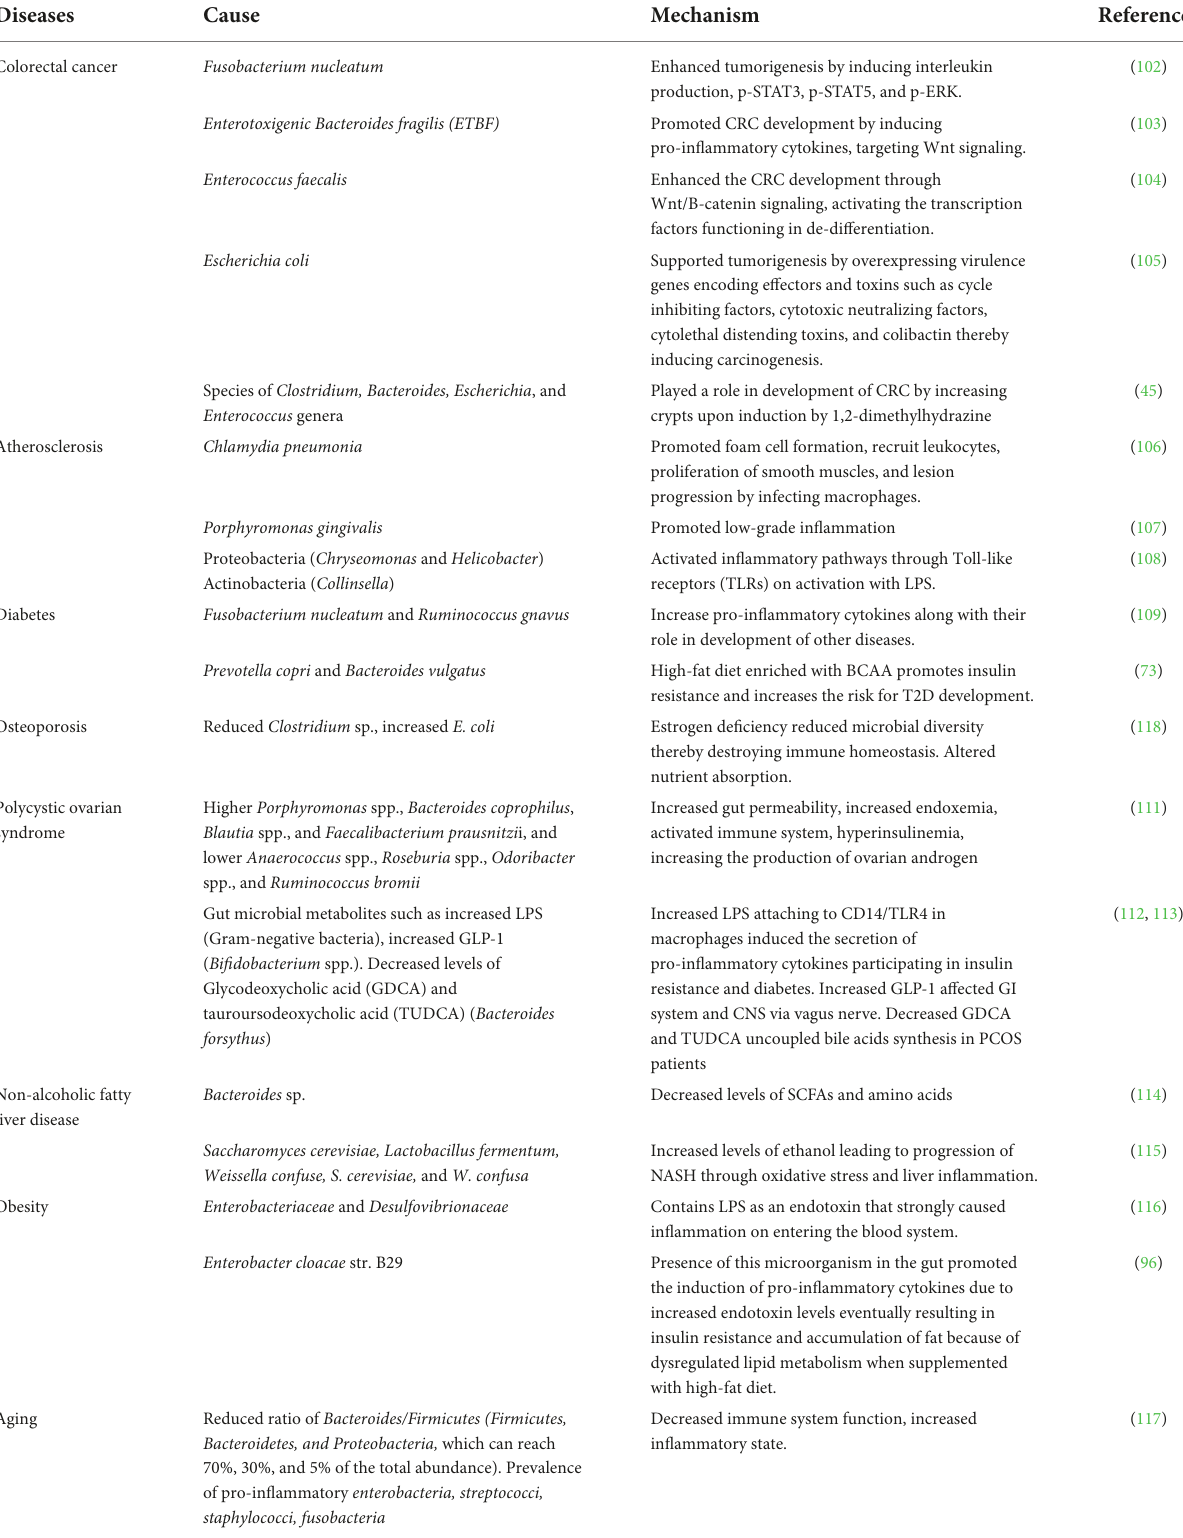
TABLE 1 Summary of causative microorganisms contributing to the pathophysiology of various NCDs and colorectal